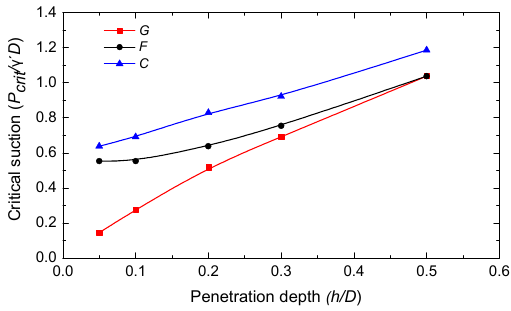
Figure 16. Relationship between the critical suction and penetration depth.